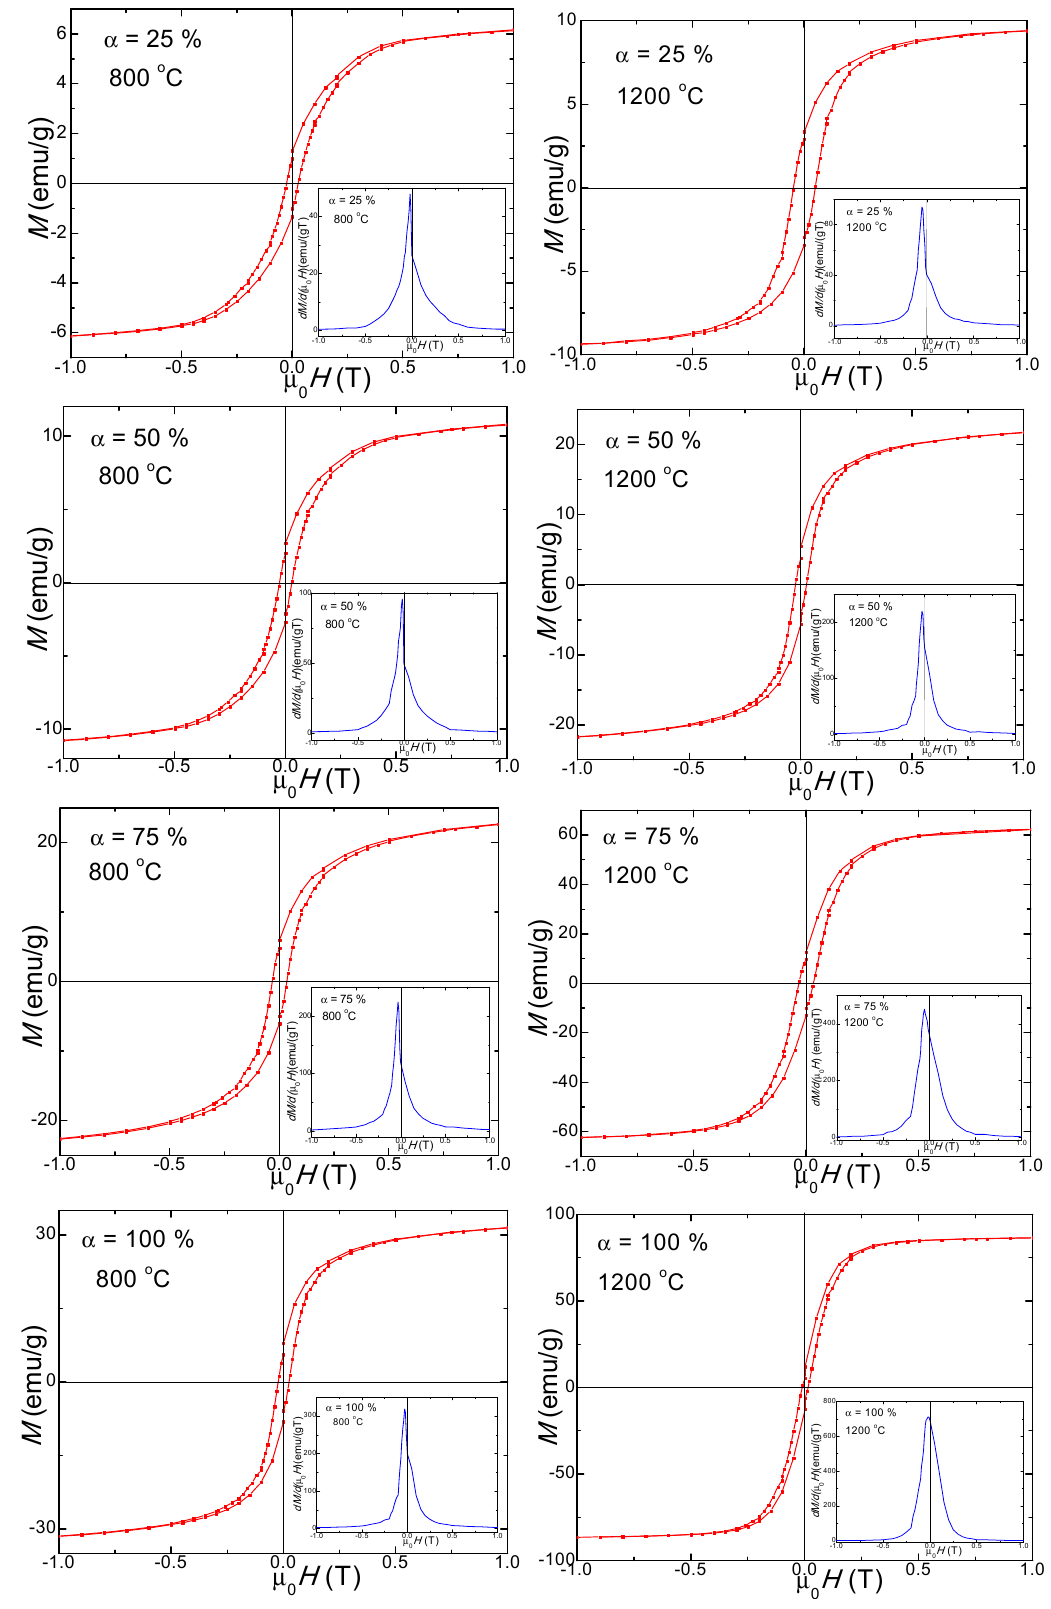
Figure 8. Magnetic hysteresis loops and magnetization derivative of (Co 0.4 Zn 0.4 Ni 0.2 Fe 2 O 4 ) α (SiO 2 ) 100 – α samples ( α = 25–100%) annealed at 800 and 1200 °C.